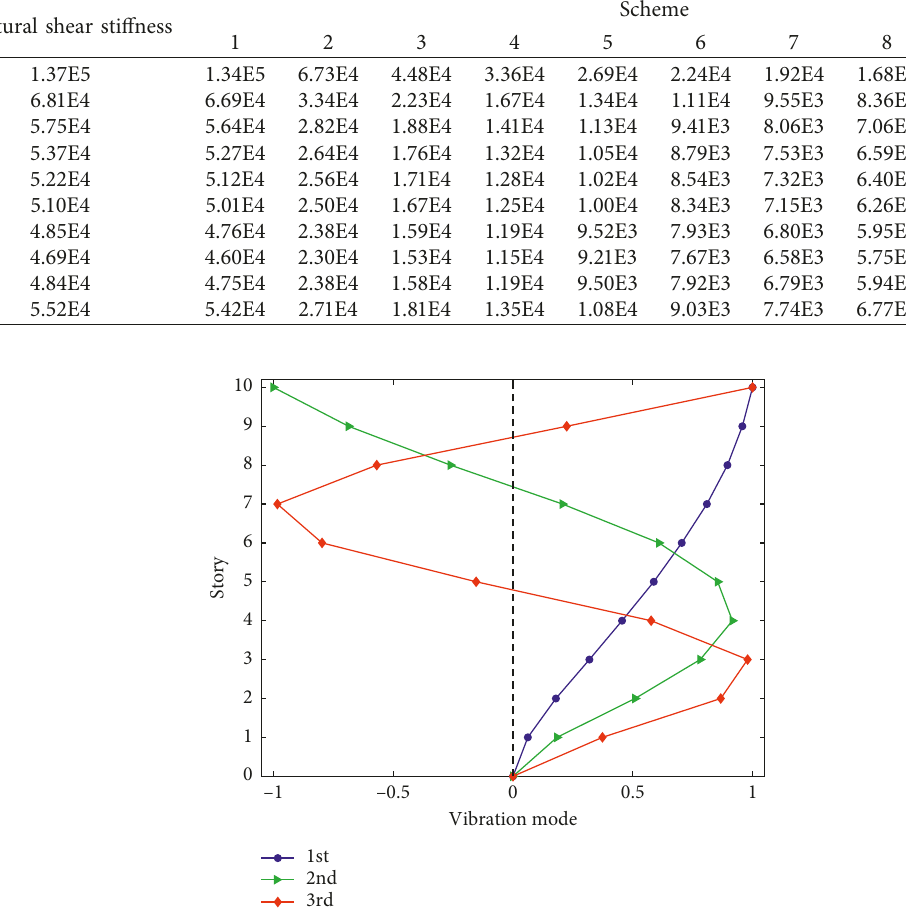
Figure 10: Vibration modes of the steel frame structure.